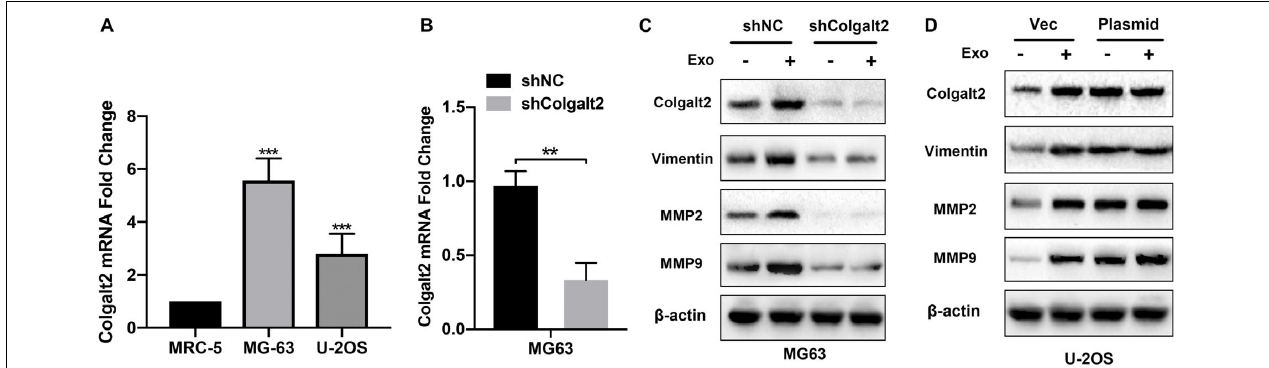
FIGURE 4 | Overexpression of COLGALT2 and confirmation of COLGALT2 inhibition and overexpression in osteosarcoma cells. (A) qRT-PCR analysis shows significantly upregulated COLGALT2 mRNA expression in MG63 and U-2OS cells compared to MCR-5 cells. (B) qRT-PCR analysis showed significantly decreased COLGALT2 mRNA expression in MG63 cells treated with COLGALT2 shRNA. (C) Immunoblotting assays showed that COLGALT2 inhibition decreased the protein expression of COLGALT2, vimentin and MMP2/9 in MG63 cells. (D) Immunoblotting assays show that COLGALT2 overexpression increased the protein expression of COLGALT2, vimentin, and MMP2/9 in U2-OS cells. *** P < 0.001, ** P < 0.01.